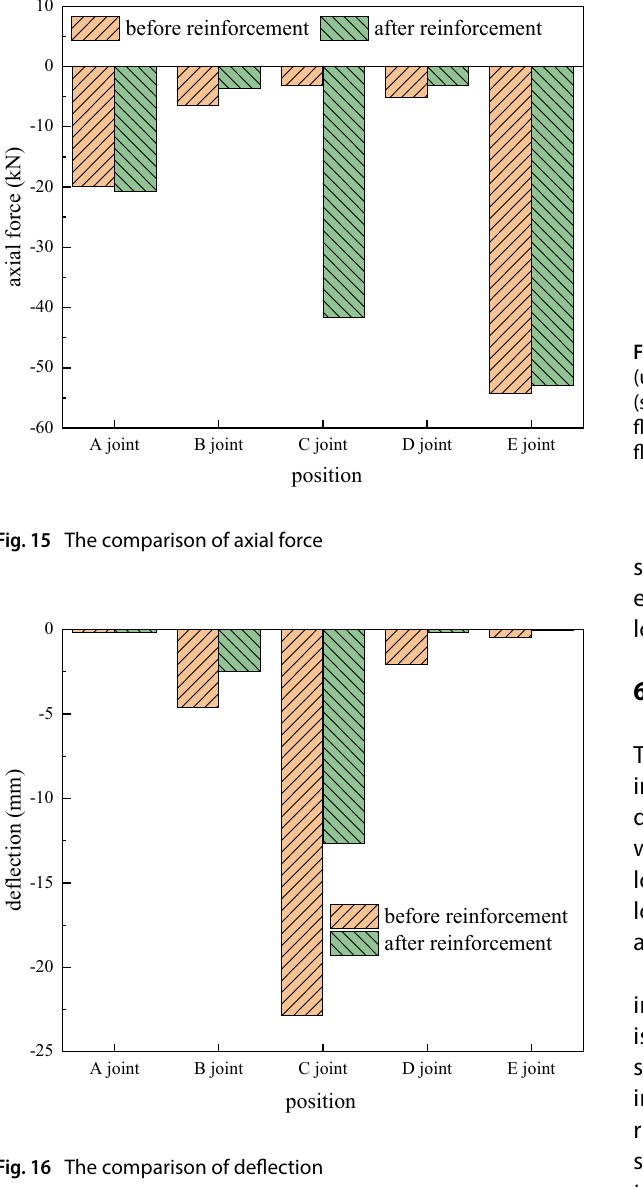
Fig. 16 The comparison of deflection